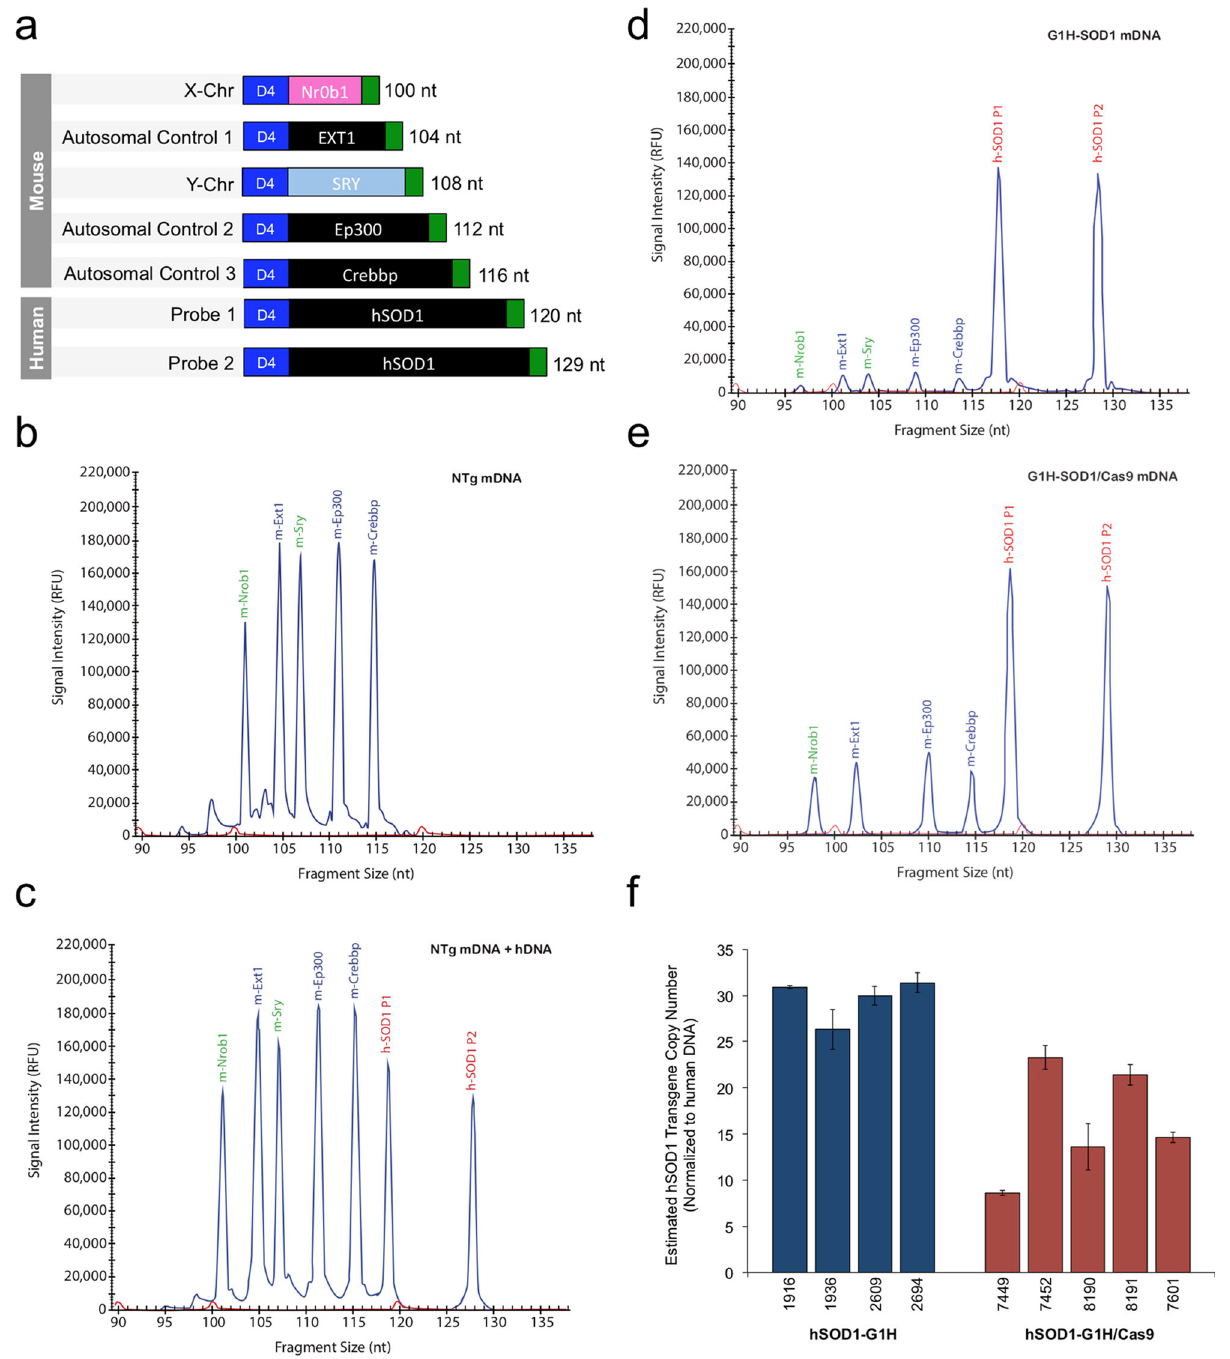
Fig. 6 Loss of hSOD1 transgene copy number in G1H/Cas9. The hSOD1 transgene copy number was determined by using multiplex ligation-dependent probe ampli fi cation (MLPA). a Five mouse-speci fi c MLPA probes were designed to hybridize to two sex chromosome-speci fi c (Nr0b1 and SRY) and three autosomal control (Ext1, Ep300, and Crebbp) genes. Two distinct MLPA probes were designed to hybridize to intron 1 (probe 1) and intron 2 (probe 2) of hSOD1 beyond the known deleted regions. The PCR ampli fi cation products generated by each probe differ in size by at least four nucleotides (nt). Nontransgenic mouse DNA (NTg mDNA) in the b absence and c presence of human DNA (1:1) was used to illustrate hSOD1 probe speci fi city. hSOD1 transgene copy number in the d G1H ( n = 4) and e G1H/Cas9 ( n = 5) mouse lines were estimated by dividing the average peak height of hSOD1 (probe 1) by the average peak height of the three mouse control genes ( e, f ). This ratio was then normalized to the ratio of mouse nontransgenic DNA spiked with human DNA. Three independent MLPA reactions were performed for each condition and the standard deviation (SD) was plotted to illustrate variation. hSOD1 transgene copies in G1H were estimated to be ~30 (29.7 ± 2.31). The lowest and the highest hSOD1 transgene copies remained in G1H/Cas9 mice were estimated to be ~9 (8.6 ± 0.25) and 23 (23.3 ± 1.28),